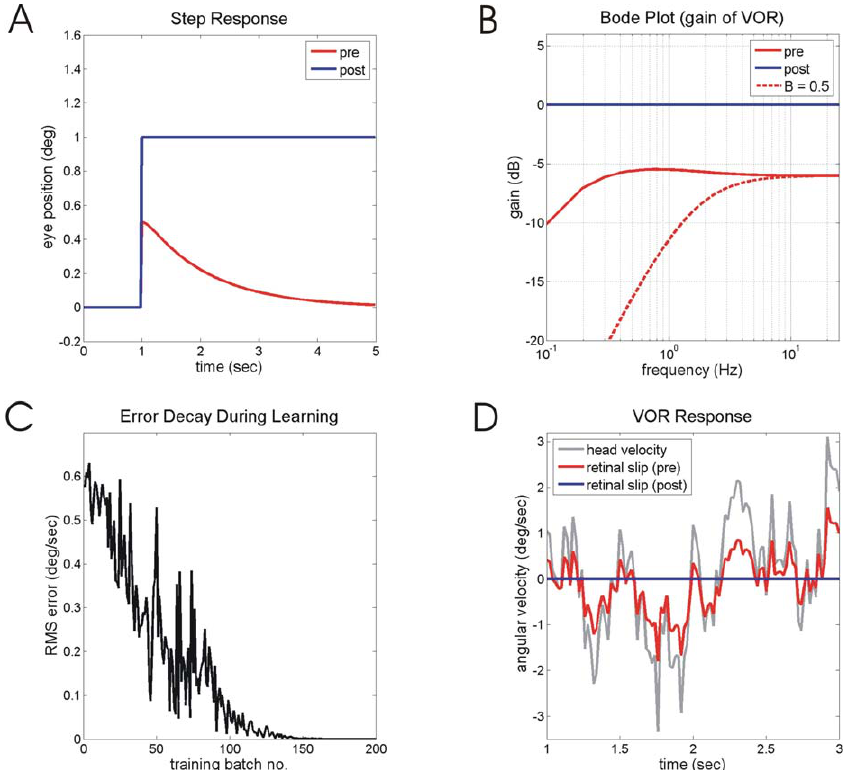
Figure 3. Performance of Model Before, During and After Training with an Undelayed Retinal-Slip Signal The plant P is first-order filter with time constant 0.1 s, and the brainstem controller B has an undergained (50%) direct pathway and a leaky integrator (TC ¼ 1 s) in the indirect pathway (details in Methods). (A) Eye-position response to sudden head displacement. The desired and post-training performances are effectively identical, so that only the latter is shown. (B) System gain for sinusoidal input signals as a function of frequency (Bode gain plot). Gain is measured as ratio of eye velocity amplitude to head velocity amplitude. Performance before training is shown both for the complete brainstem controller ( ‘‘ pre ’’ ), and for the brainstem controller as simple gain ( ‘‘ B ¼ 0.5 ’’ ), which corresponds to the direct pathway on its own. After training, the desired and post-training performances overlap and only the latter is shown. (C) Decline in retinal-slip amplitude with training. Root-mean-square (RMS) retinal-slip amplitudes, measured over a 5 s training batch, plotted against number of training batches. (D) Example of retinal-slip to mixed-frequency head-velocity input before and after training.